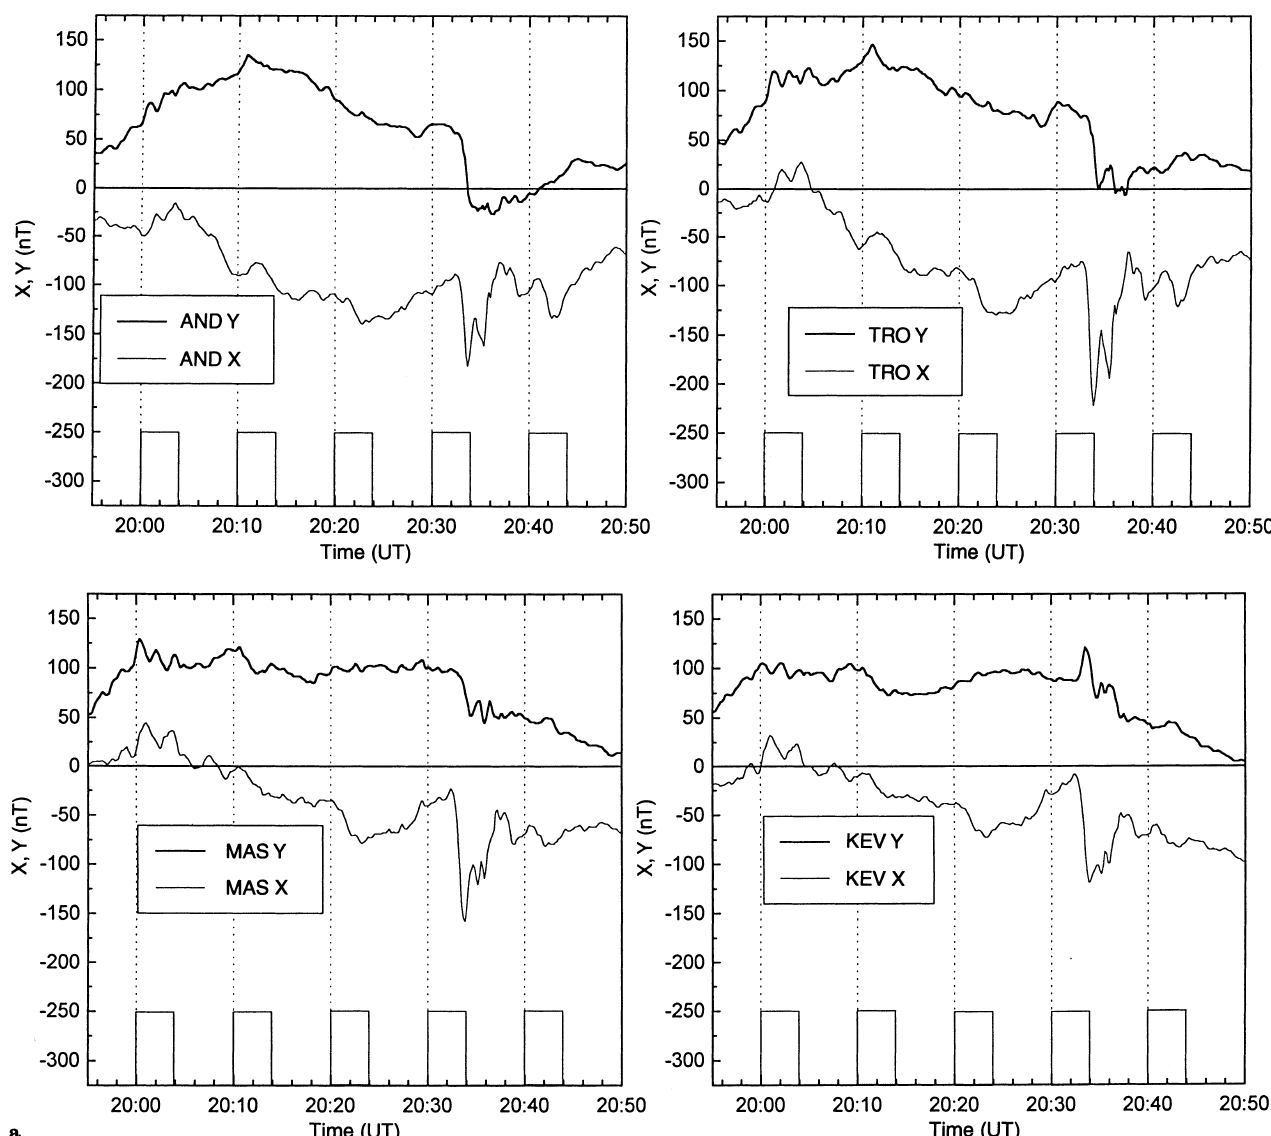
Fig. 4a, b. Perturbations of the X and Y magnetic field components from the quiet level during heating experiment on 17 February 1996 for IMAGE magnetometers, a along the latitude from AND to KEV